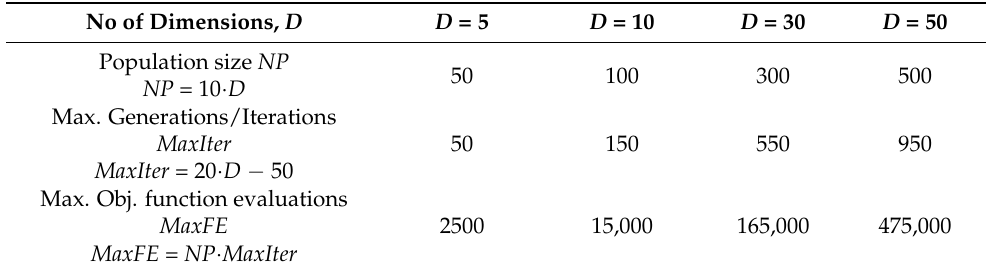
Table 2. Optimization parameters and convergence criteria used for each category of problems based on the number of dimensions.